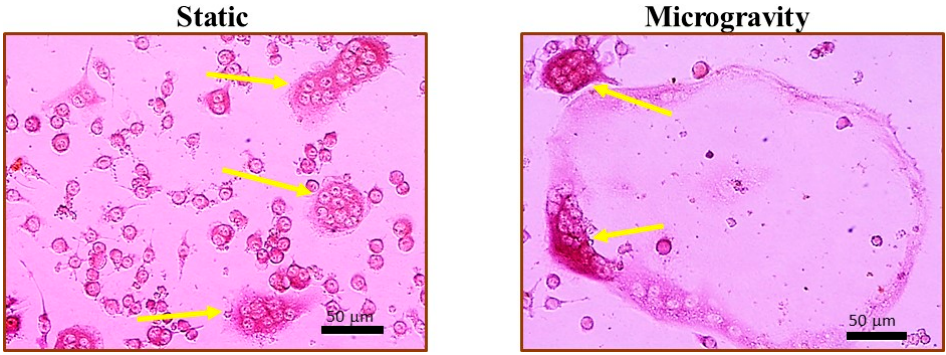
Figure 7. Multinucleated osteoclasts (pointed by arrows) formed in cells after a 5-day osteoclast culture in RANKL. Cells were maintained in static conditions or under simulated microgravity for 48 h immediately prior to osteoclast culture.